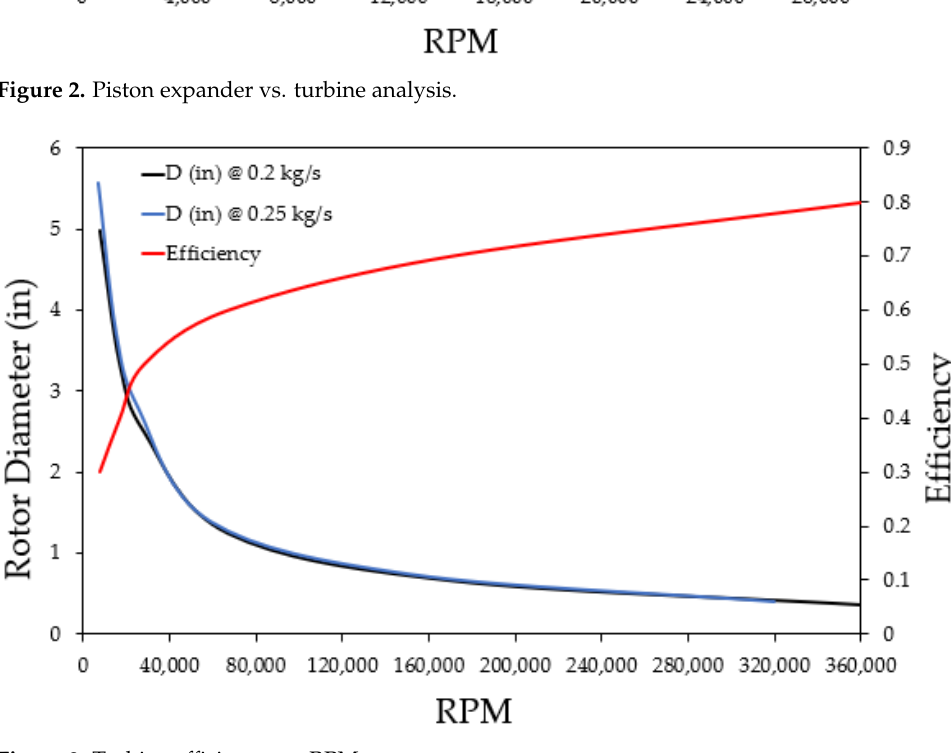
Figure 3. Turbine efficiency vs. RPM.